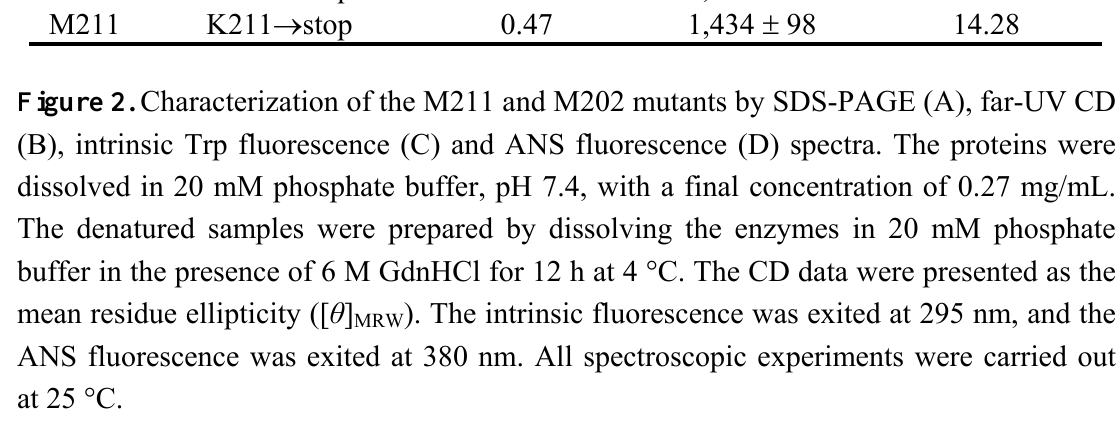
Table 1. Characterization of the purified WT TcSOD and the mutants.